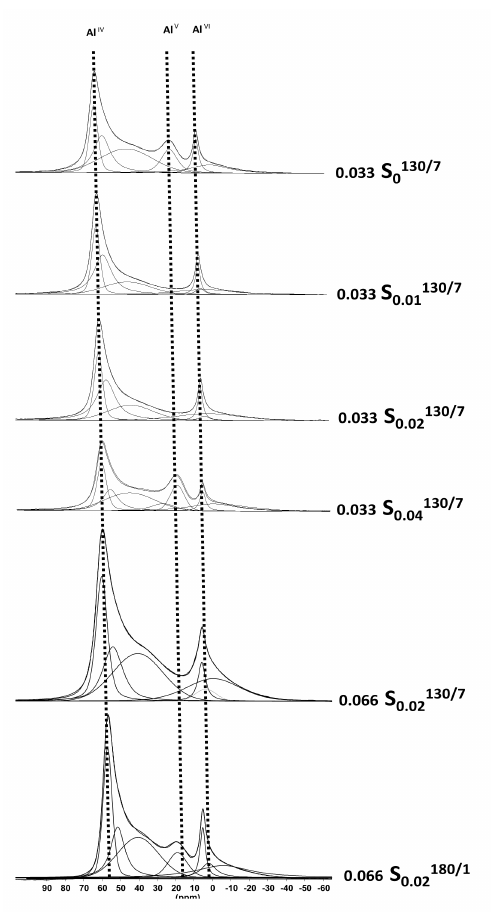
Figure 4. 27 Al-MAS-NMR spectra of the calcined